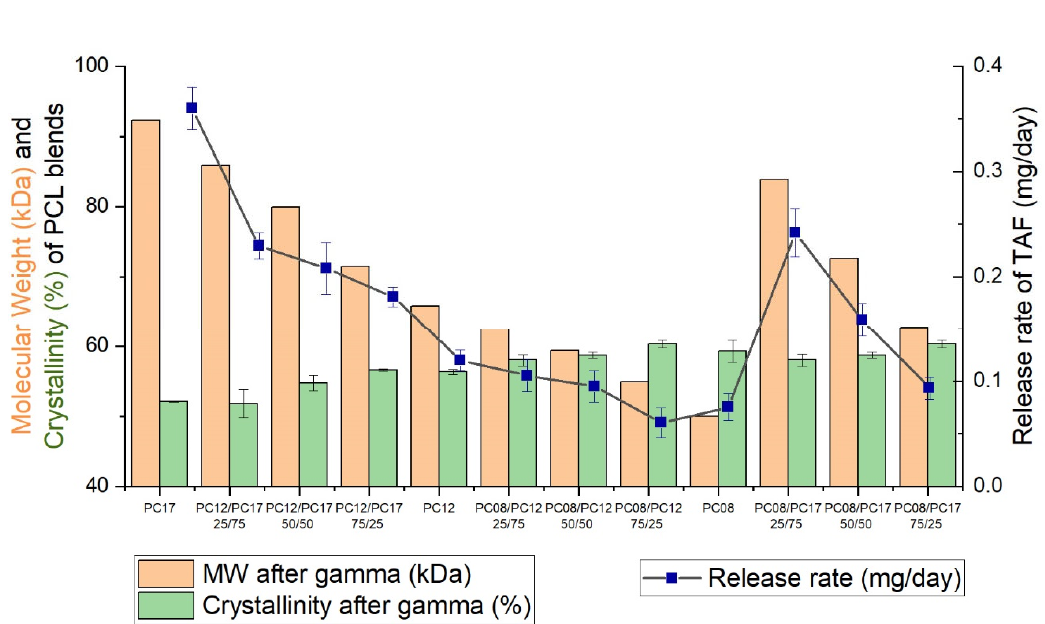
Figure 6. The relationships between the release rate of TAF and various properties of PCL formulations. The release rates of TAF were normalized to the surface area of an implant with dimensions of 2.5 mm OD and 40 mm length (i.e., 314 mm 2 ). The in vitro release assessments were performed in triplicate. The weight average MW and % crystallinity were determined using hollow extruded tubes without drug formulations. The % crystallinity reflects the mean values ± standard deviation of three independent measurements, whereas the MW value was reported based on one measurement.